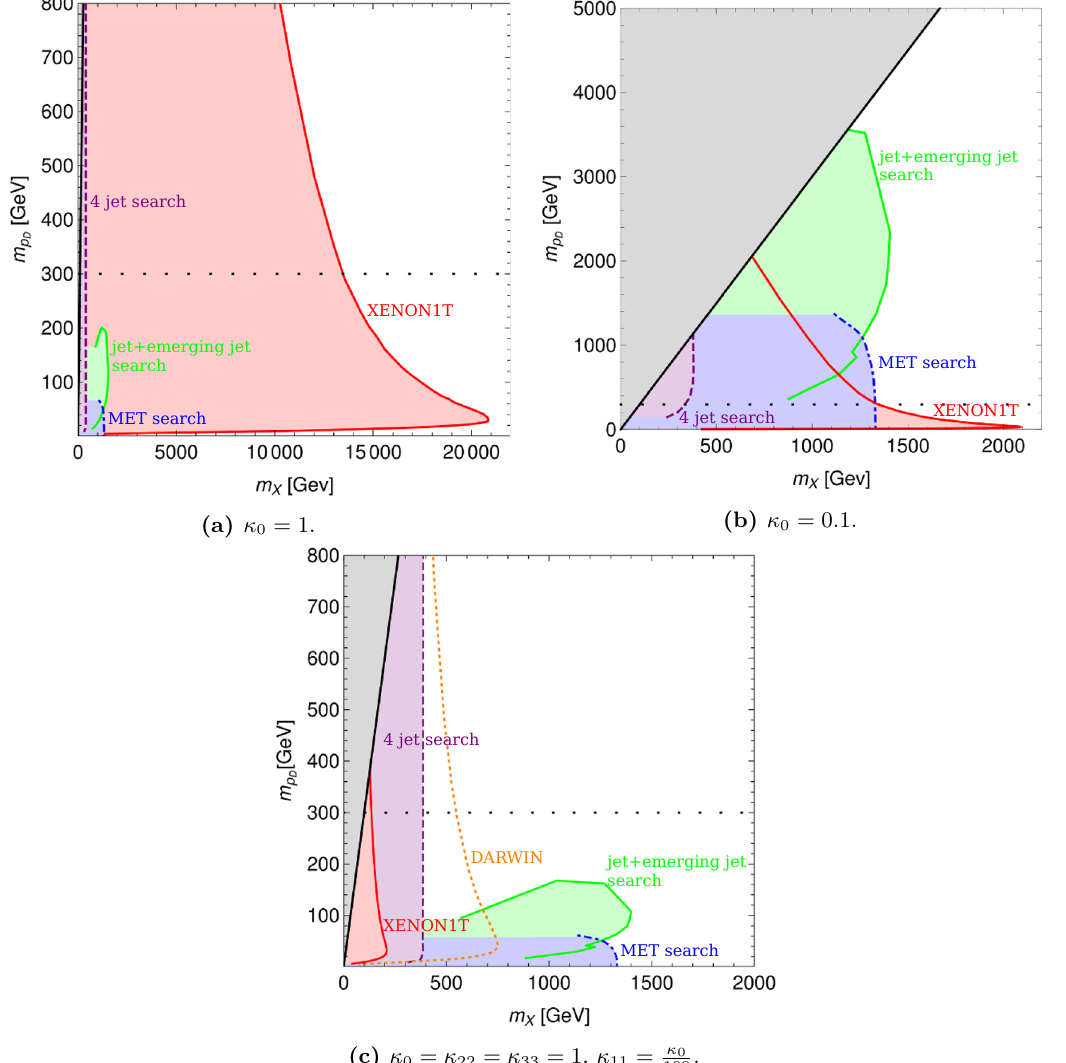
Figure 14. Constraints on dark QCD in the m X − m p dot-dashed blue and dashed purple regions are excluded from the emerging jet, MET and four jet searches. The red region from XENON1T. The dotted orange line shows the expected DARWIN exclusion limit. Above the black lines the dark pion mass is larger than the mediator mass, while above the loosely dotted line the dark pion mass is larger than 100